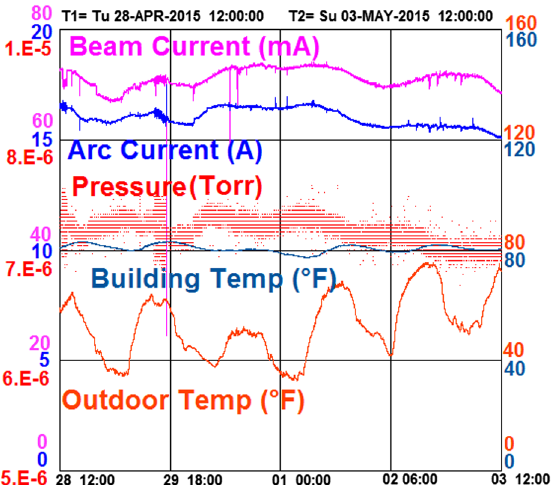
FIG. 7. Datalog plot of the beam current, arc discharge current, vacuum pressure and local temperatures over a five-day period using the solenoid gas valve in the source.